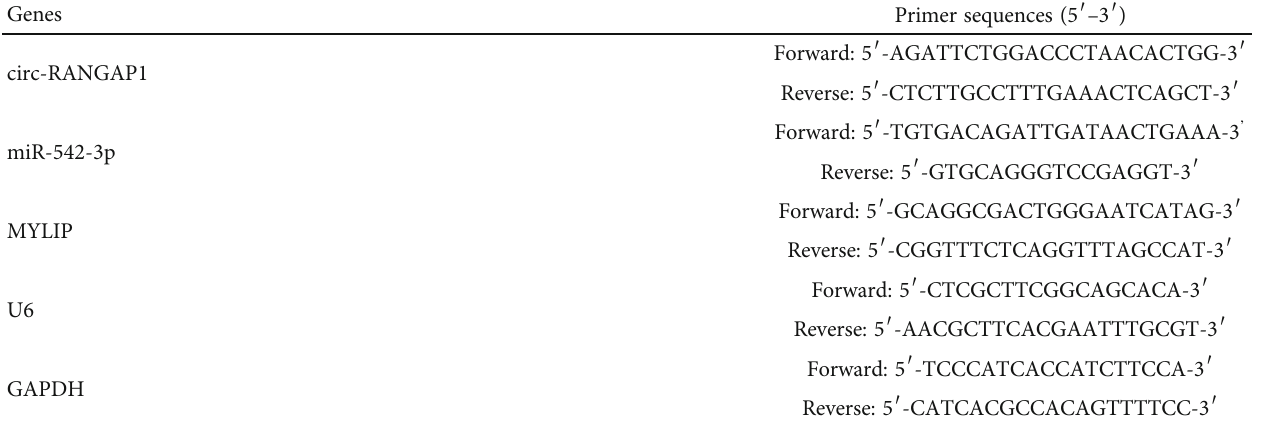
Table 1: Primer sequences.